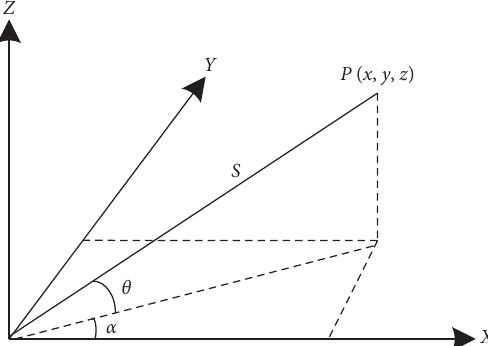
Figure 1: The point coordinates in the coordinate system of the 3D laser